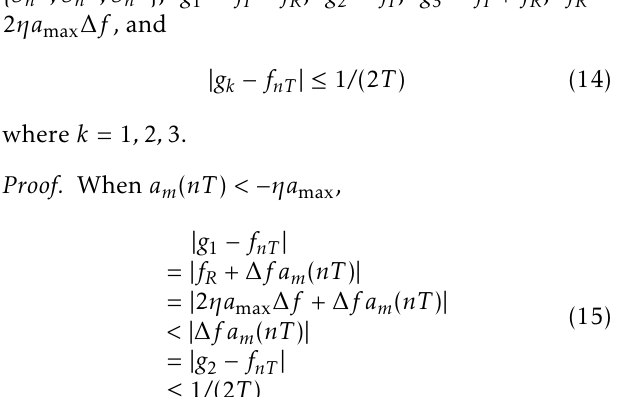
P roposision 1: The demodulator shown in figure S n − 2 is the 1.5-bit FM 4 with output Y n = arg max i S ( i ) n demodulator defined in Def inition , where S n :=